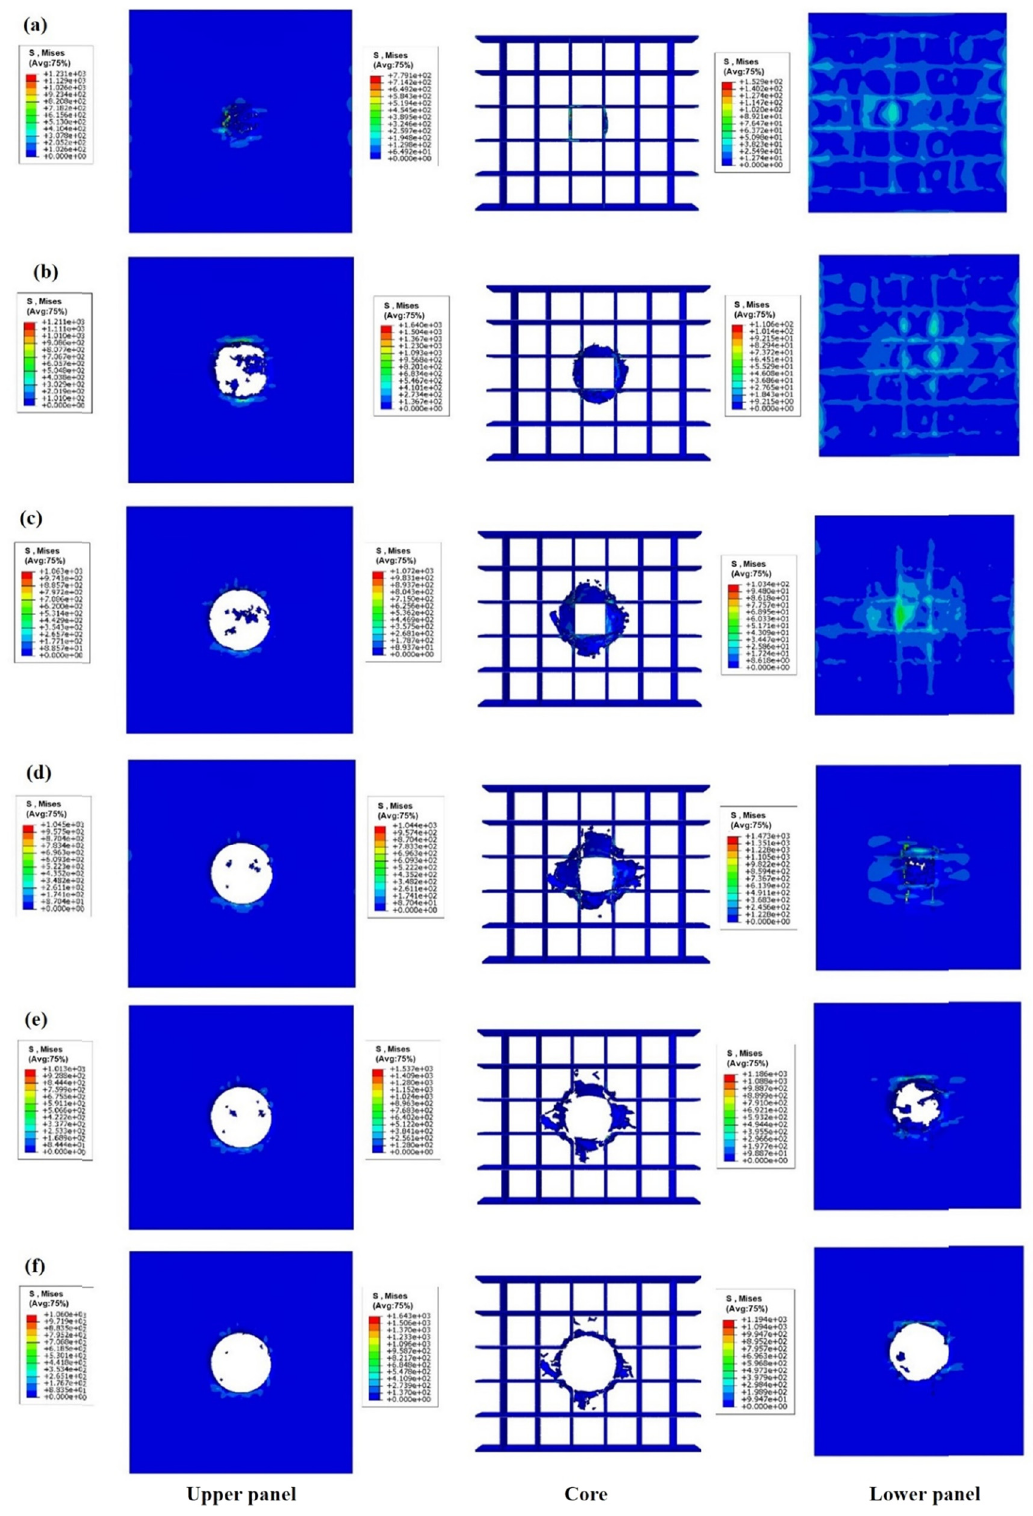
Figure 12: Impact damage expansion process of upper and lower panels and the core of grid sandwich structure Q - 8 - 10. ( a ) t = 0.25 ms, ( b ) t = 0.75 ms, ( c ) t = 1.25 ms, ( d ) t = 1.75 ms, ( e ) t = 2.25 ms, and ( f ) t = 2.75